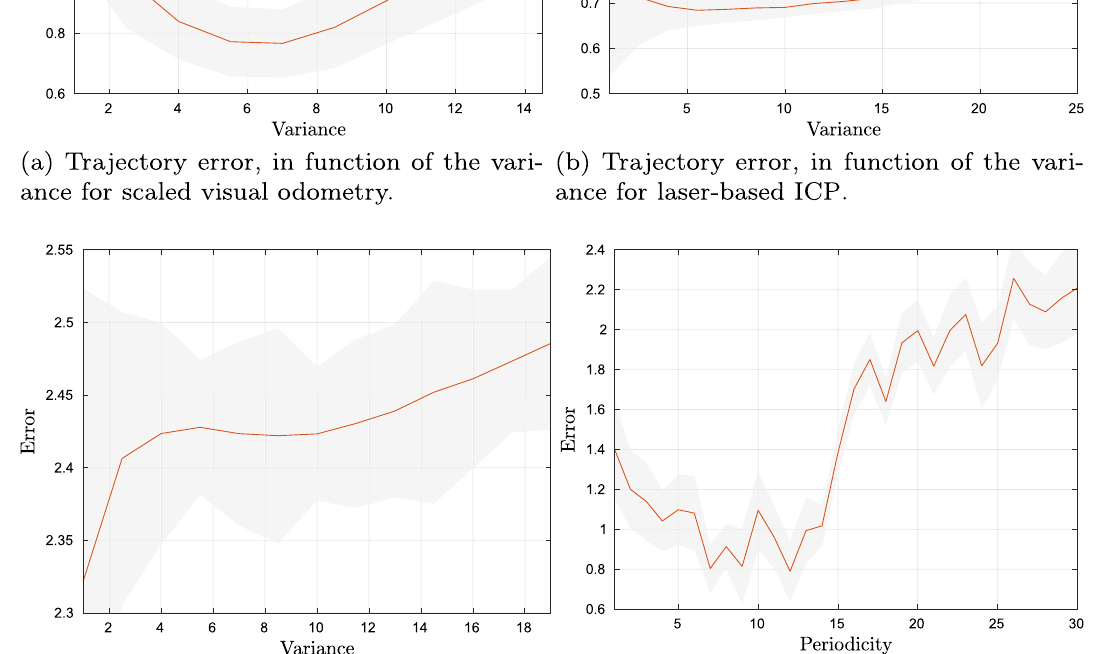
values (lowest 1%), obtained by fixing a given parameter and look- ing at error values against all other parameter combinations. The shaded area represents the standard deviation of the error